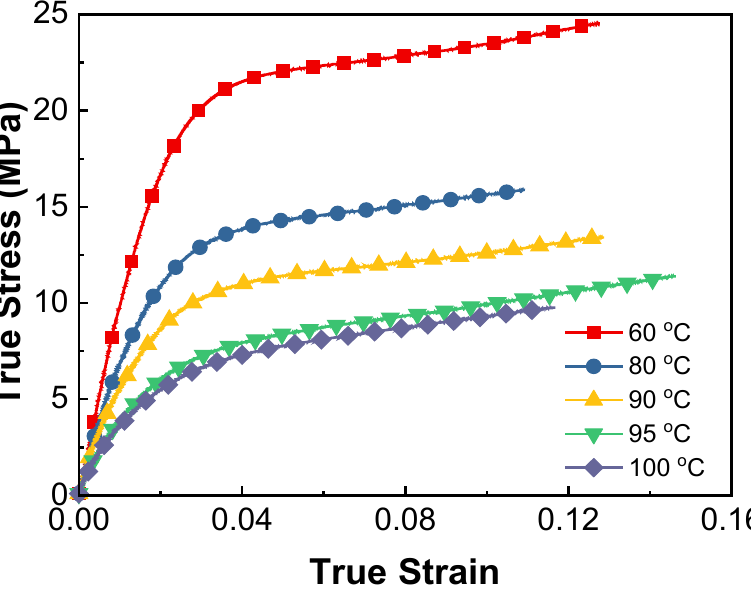
Figure 6. Stress–strain curve of Gb/Pb acrylic under different temperature at the same extension rate of 1.667 × 10 −4 s −1 .